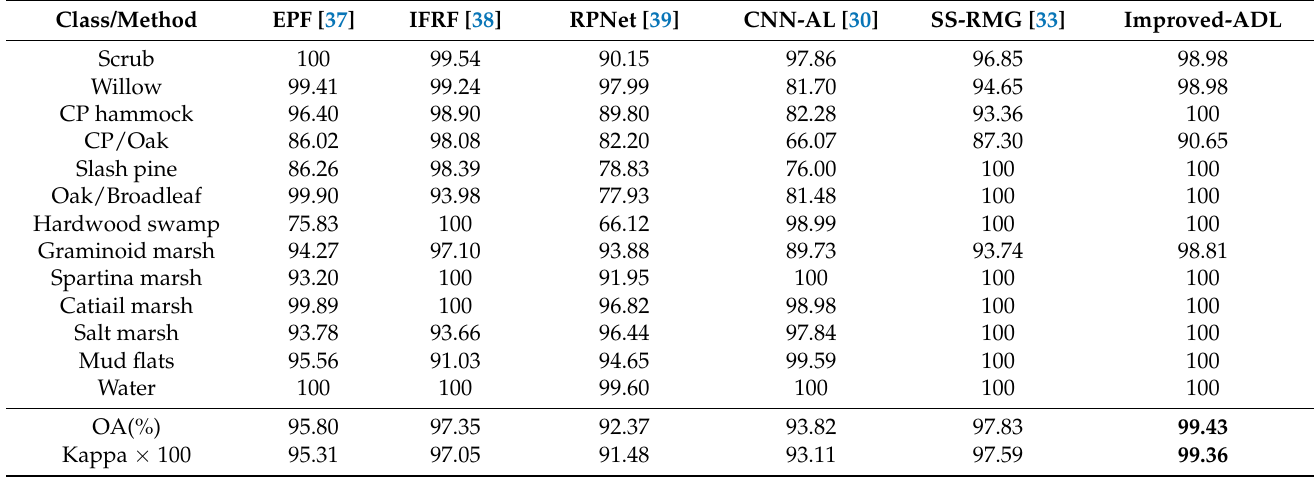
Table 8. Classification results of different methods on the Kennedy Space Center dataset.